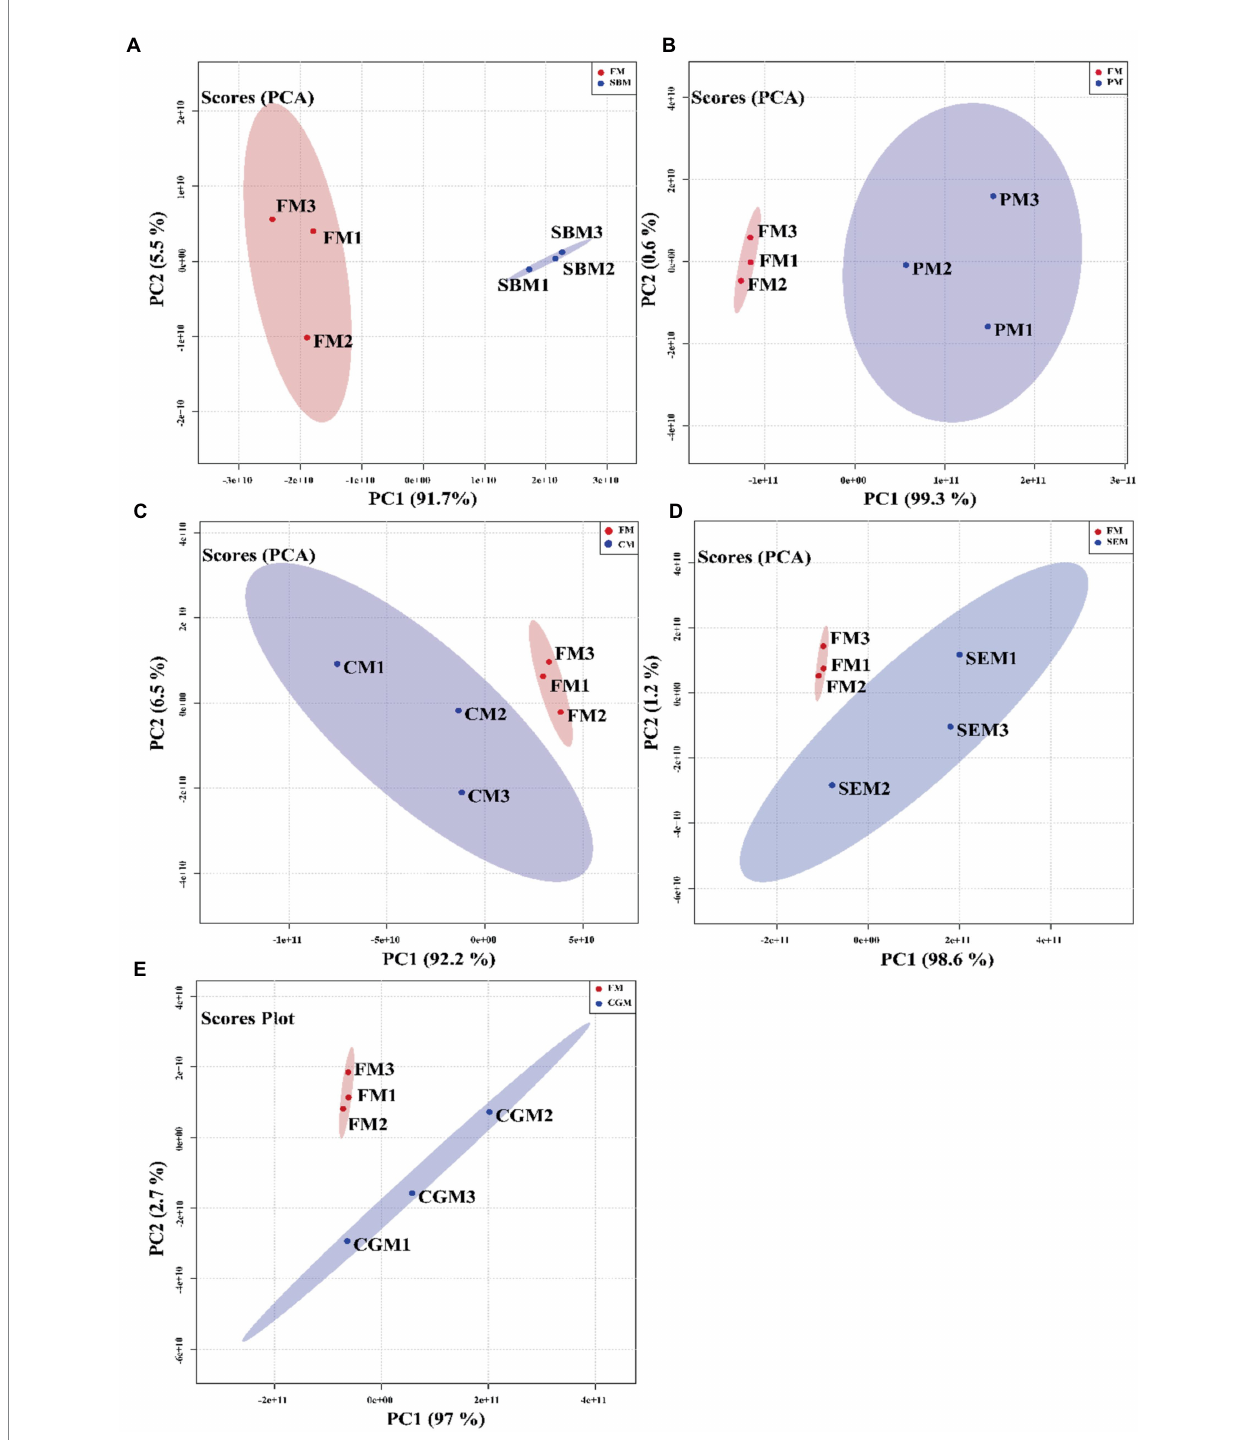
FIGURE 3 The PCA score plots for the metabolomics profiles in (A) FM vs. SBM; (B) FM vs. PM; (C) FM vs. CM; (D) FM vs. SEM; (E) FM vs.